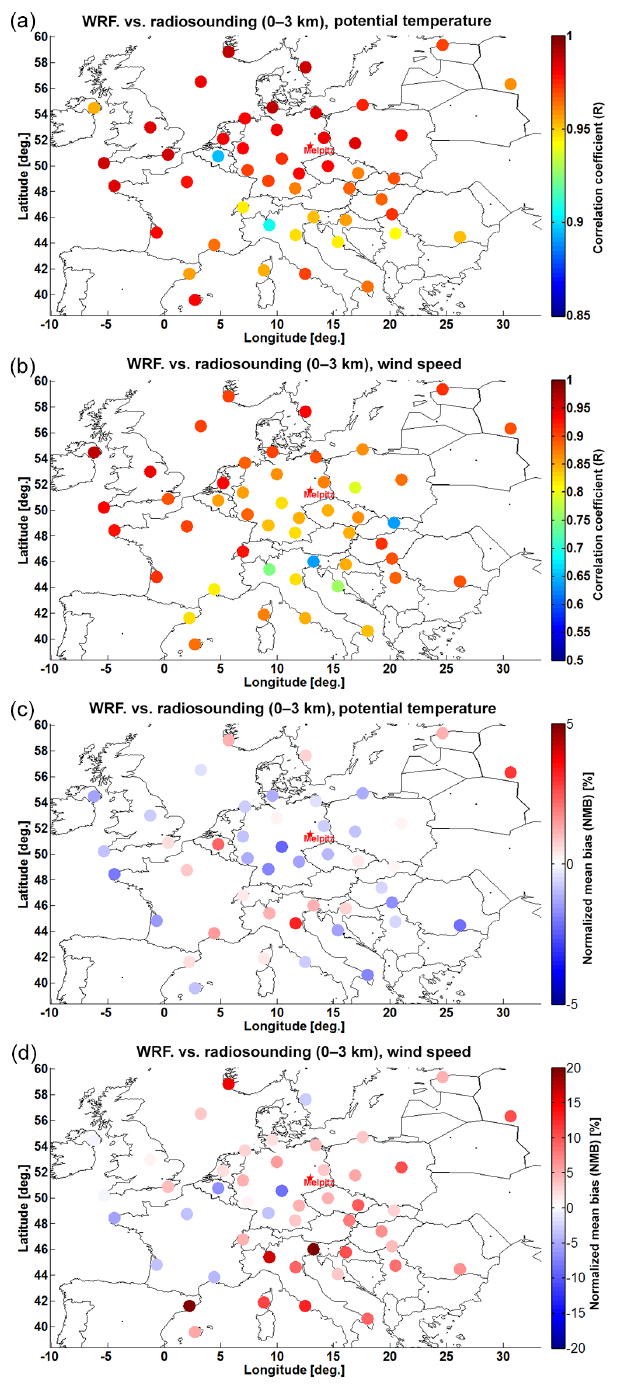
Figure 3. Comparison between WRF-Chem model and radiosound- ing measurements (0–3km). Melpitz is marked as red star. (a) R map of potential temperature; (b) R map of wind speed; (c) NMB map of potential temperature; (d) NMB map of wind speed. Note that the panels have the different color-bar scale.